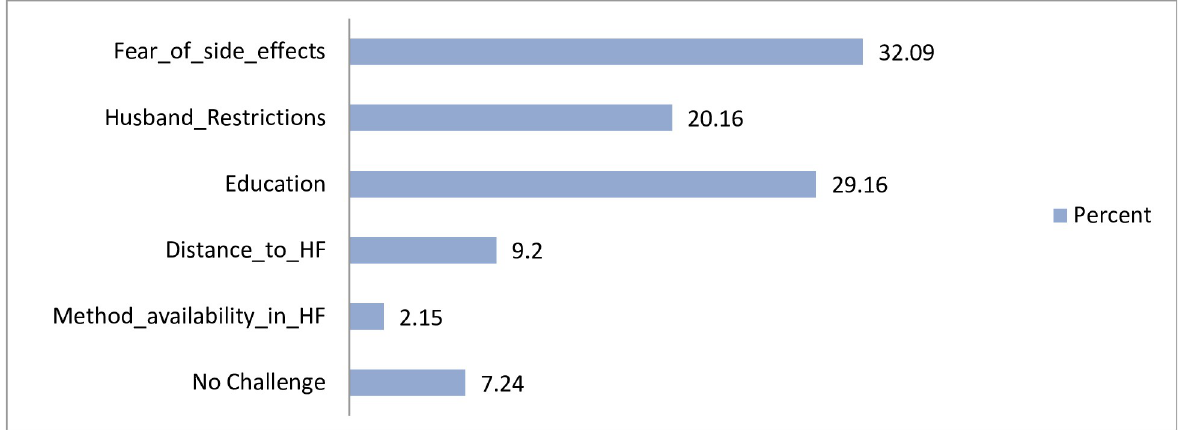
Fig 3. Challenges of postpartum modern contraceptive